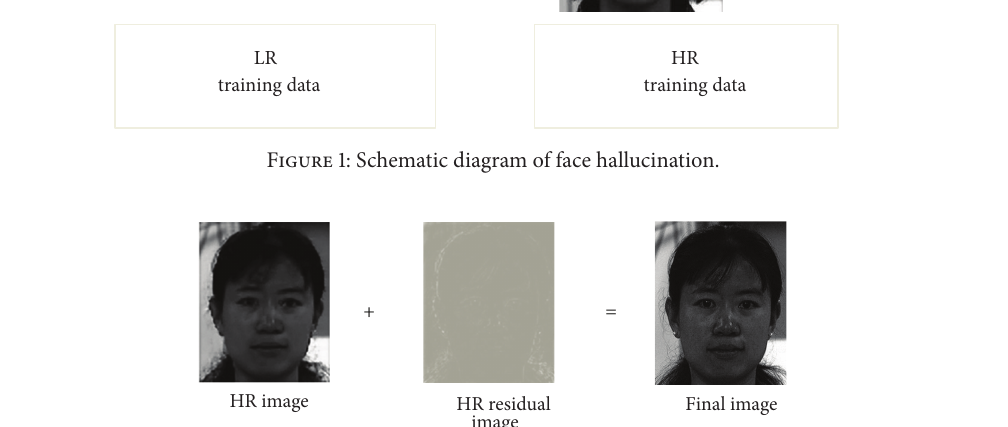
Figure 2: Framework for recovering high-frequency components in face